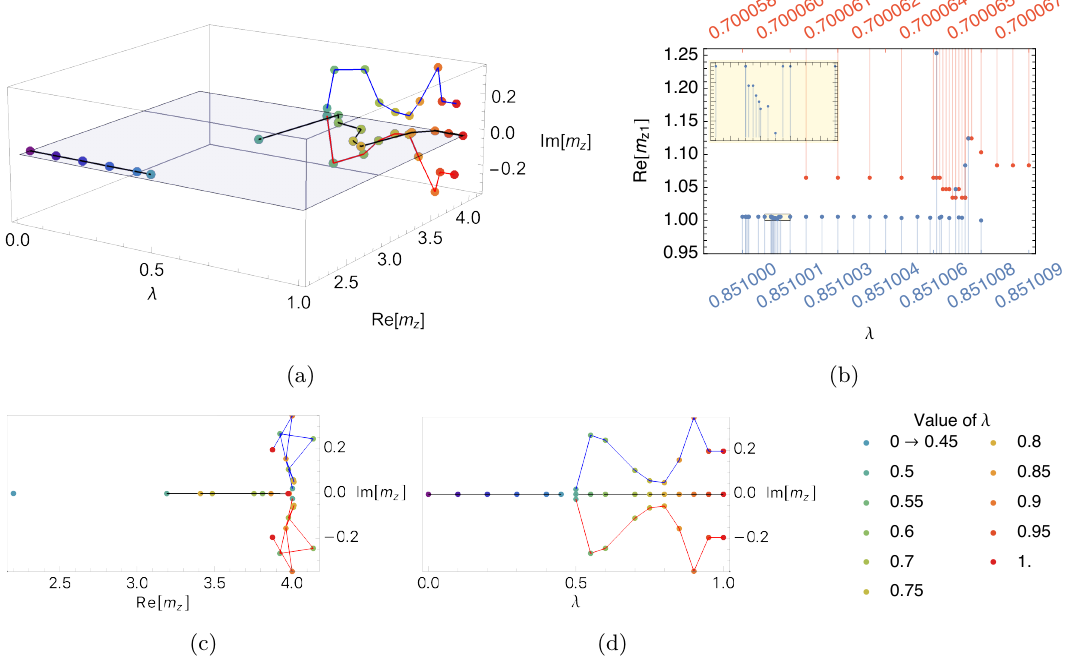
= Re( m ) , as z 1 z 1